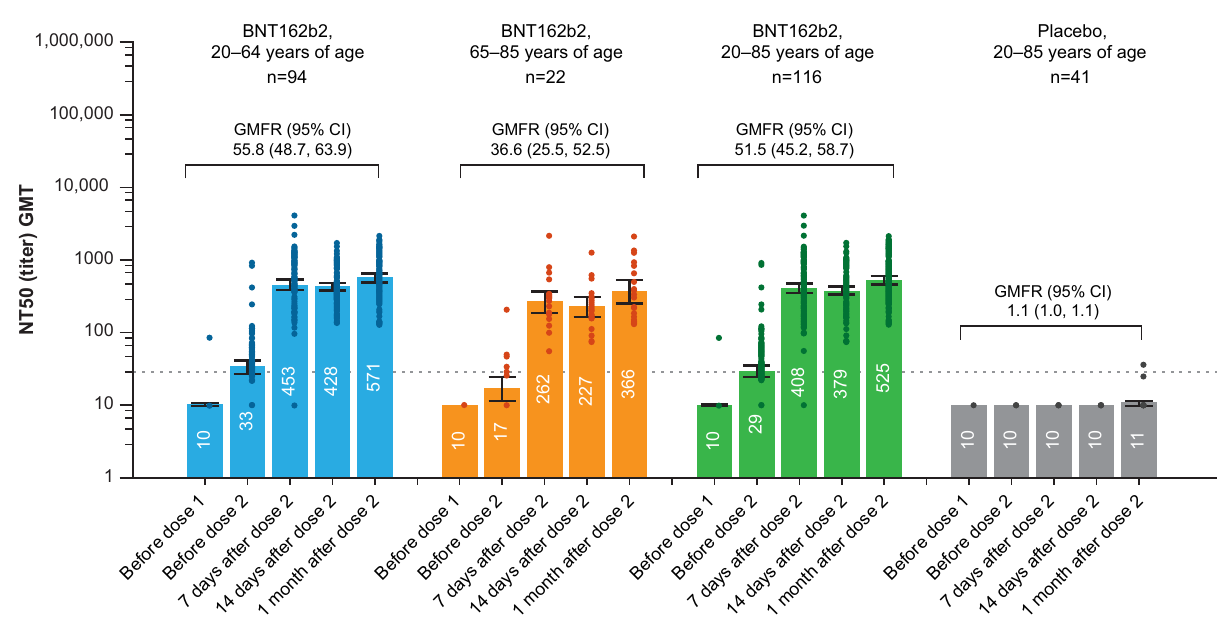
Fig. 3 Geometric mean titers and geometric mean fold rises of SARS-CoV-2 50% neutralizing titers for participants by age group and overall. Results are for the evaluable immunogenicity population. Data are presented as geometric mean values with associated 95% CIs shown as error bars. Dots represent individual 50% neutralizing titers; individual dots correspond with discrete visits for each time point and may be superimposed. Numbers within bars are the geometric means. n = Number of participants with valid and determinate assay results. GMTs, GMFRs, and two-sided 95% CIs were calculated by exponentiation of the mean logarithm of the titers or fold rises and the corresponding CIs (based on the Student t distribution). GMFRs are from before dose 1 to 1 month after dose 2. Assay results below the LLOQ (20, dashed line) were set to 0.5 × LLOQ. CI con fi dence interval, GMFR geometric mean fold rise, GMT geometric mean titer, NT50 50% neutralizing titer, LLOQ lower limit of quantitation, SARS-CoV-2 severe acute respiratory syndrome coronavirus 2. In the placebo group, n = 41 except before dose 2, when n = 40.